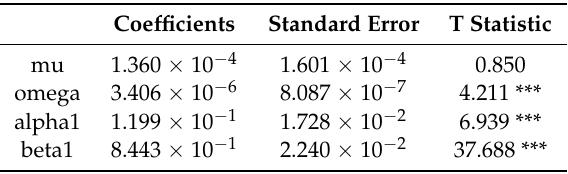
Generalised Autoregressive Conditional Heteroscedasticity (GARCH) (1,1) fitted to FTSE